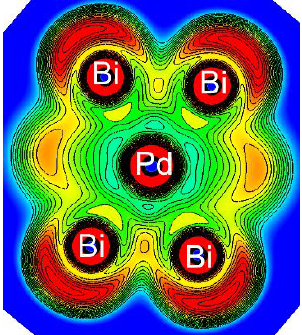
Figure 7. ELF cross-section passing through the Pd-Bi contacts in PdBi 104 + .